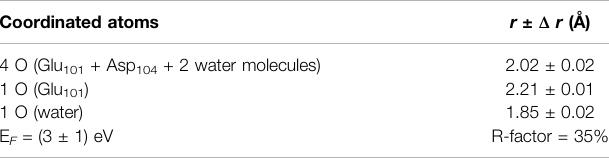
TABLE 4 | Co 2+ -ligand distances and Fermi energy shift at the end of the EXAFS fi t. Note that the carboxylic group of Glu 101 contributes to the octahedral coordination with two oxygen